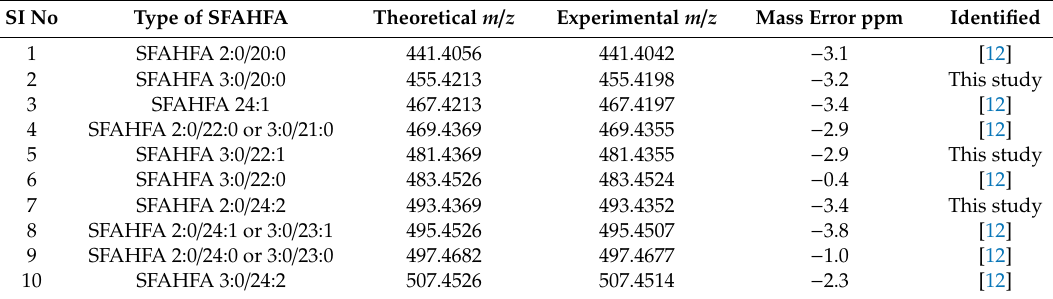
Table 1. List of all the DMED-labeled-SFAHFAs identified with their exact